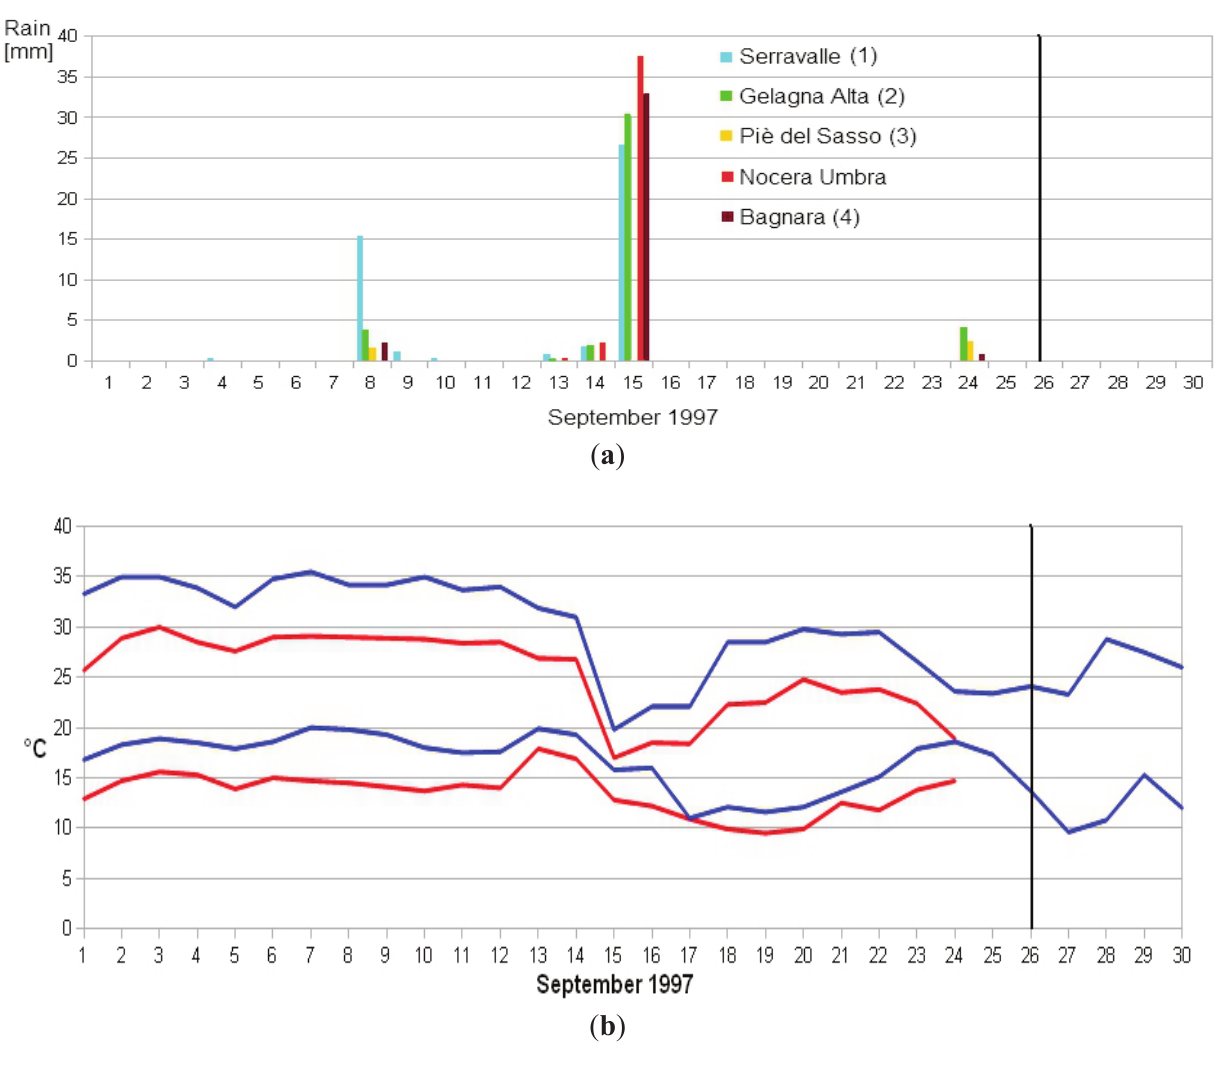
Figure 3. Rain data from the five meteorological stations. ( a ) rain data after September 22 were lost from Serravalle as it was strongly damaged by the quake; minimum and maximum daily temperatures recorded at Nocera Umbra, in red, and at Foligno, in blue, meteorological stations ( b ) temperature data after September 24 were lost from Nocera Umbra as it was strongly damaged by the quake; the main shock time is indicated by a black vertical